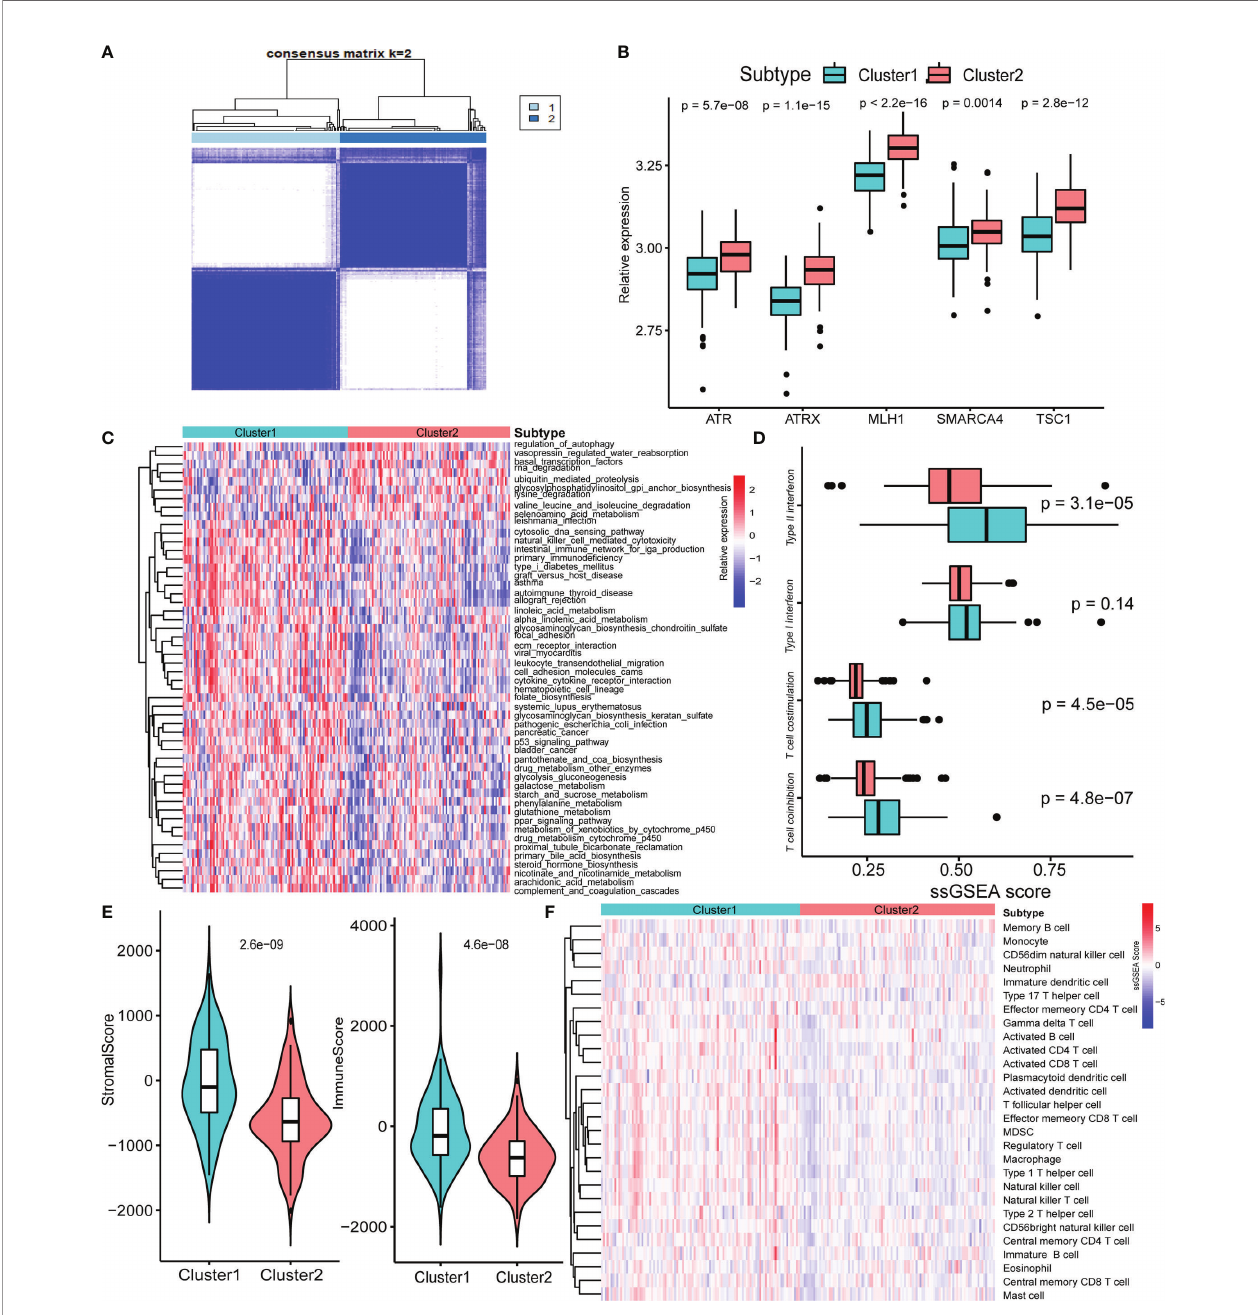
FIGURE 2 | Biological characteristics of fi ve-pathway-related molecules. (A) Unsupervised clustering of 5-pathway-related molecules. (B) The fi ve-molecule expression level in the two-pathway-related molecules patterns. (C) Heatmap of GSVA enrichment analysis presents the activation state of biological signaling pathways in two-pathway-related molecules patterns. (D) Box plots of median ssGSEA scores of speci fi c antitumor immune responses associate with T-cell activation between two-pathway-related molecule patterns. (E) Differences in the StromalScore and ImmuneScore between two-pathway-related molecule patterns. (F) Heatmap of ssGSEA scores of gene sets indicative of speci fi c immune cell populations between two-pathway-related molecule